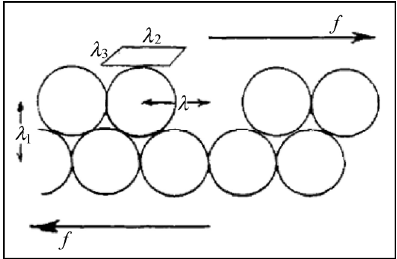
Fig. 4 Eyring’s schematic model of viscous flow of simple mole- cules. Reproduced with permission from [14]. Copyright ACS,